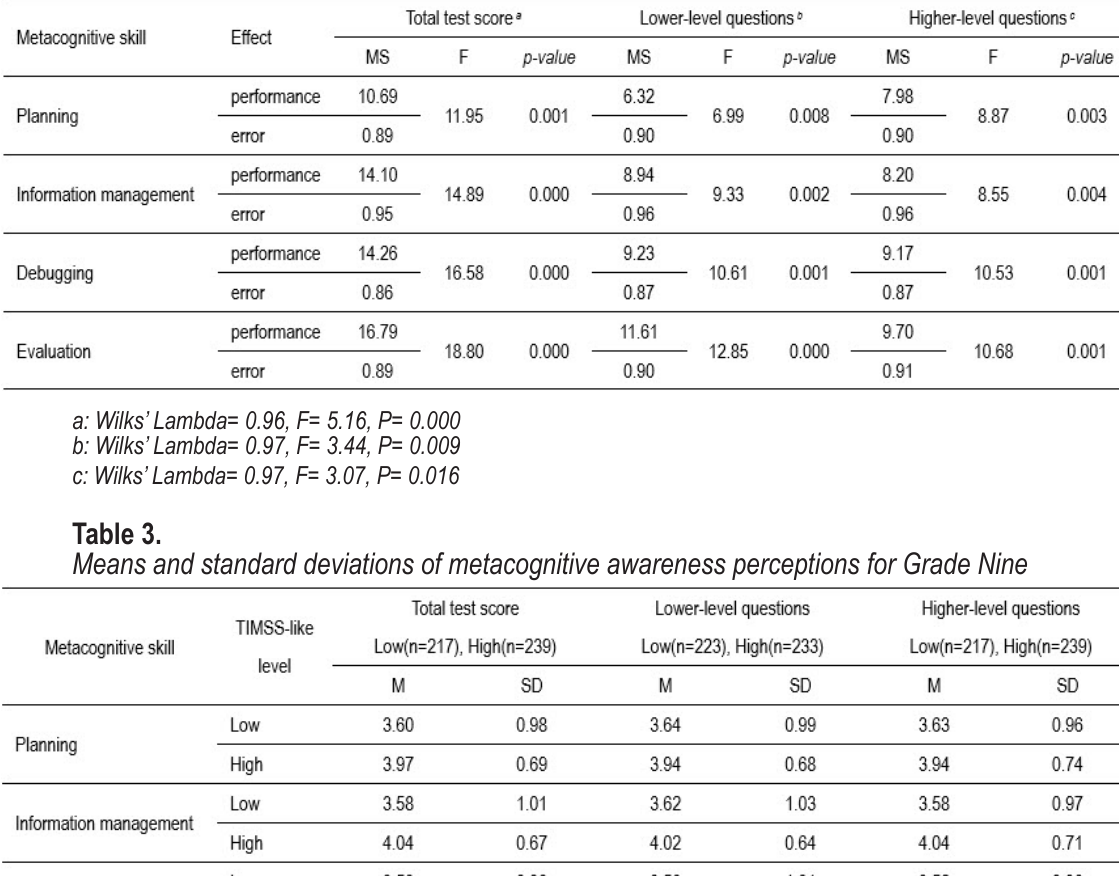
MANOVA results of between-subjects effects for metacognitive awareness perceptions and TIMSS- like total performance of Grade Five (df=1, 475)